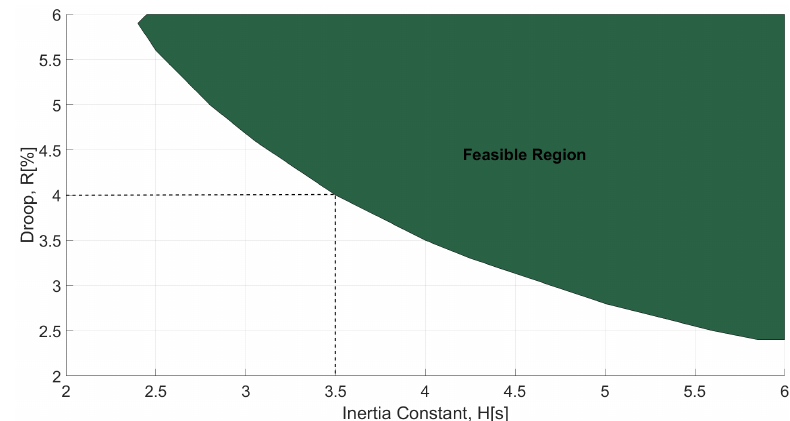
Figure 13. Feasibility of different R for different H for Cross-Compound Fossil Steam.